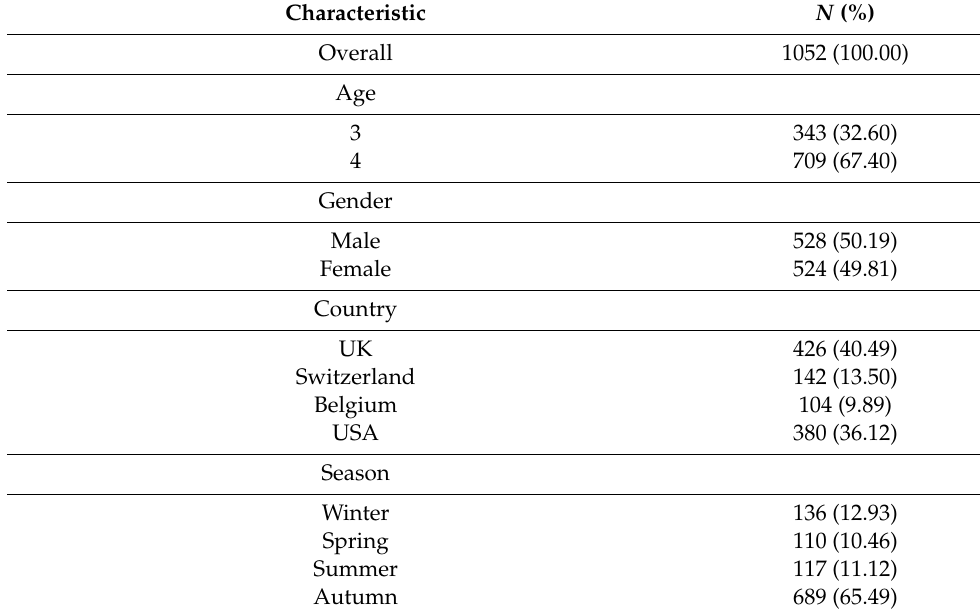
Table 1. Sociodemographic characteristics of